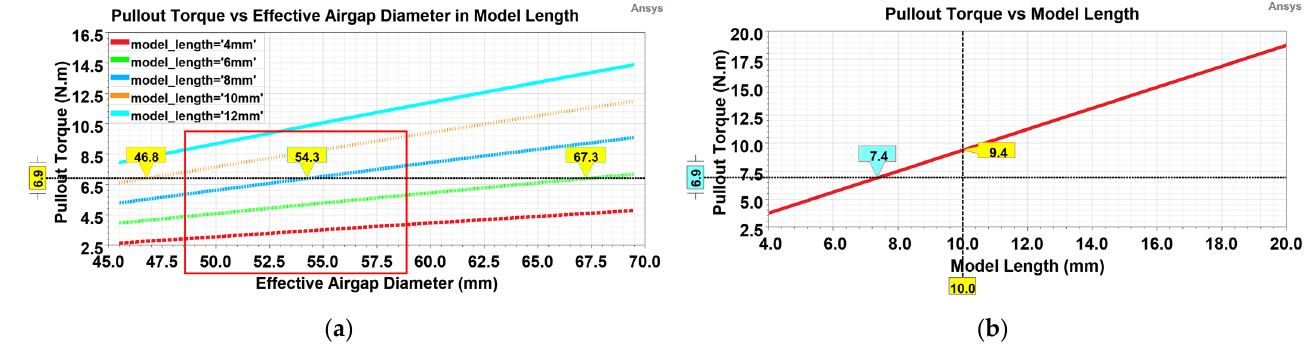
Figure 7. Pullout torque versus ( a ) Effective air gap length in model length; ( b ) Model length.